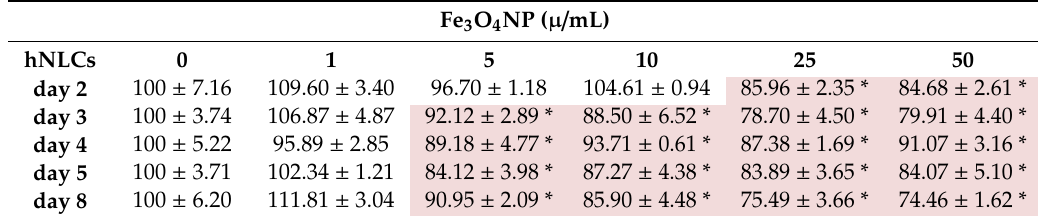
Table 3. ATP content evaluation in hNLCs plus Fe 3 O 4 NPs (1–50 µ g / mL) over time.